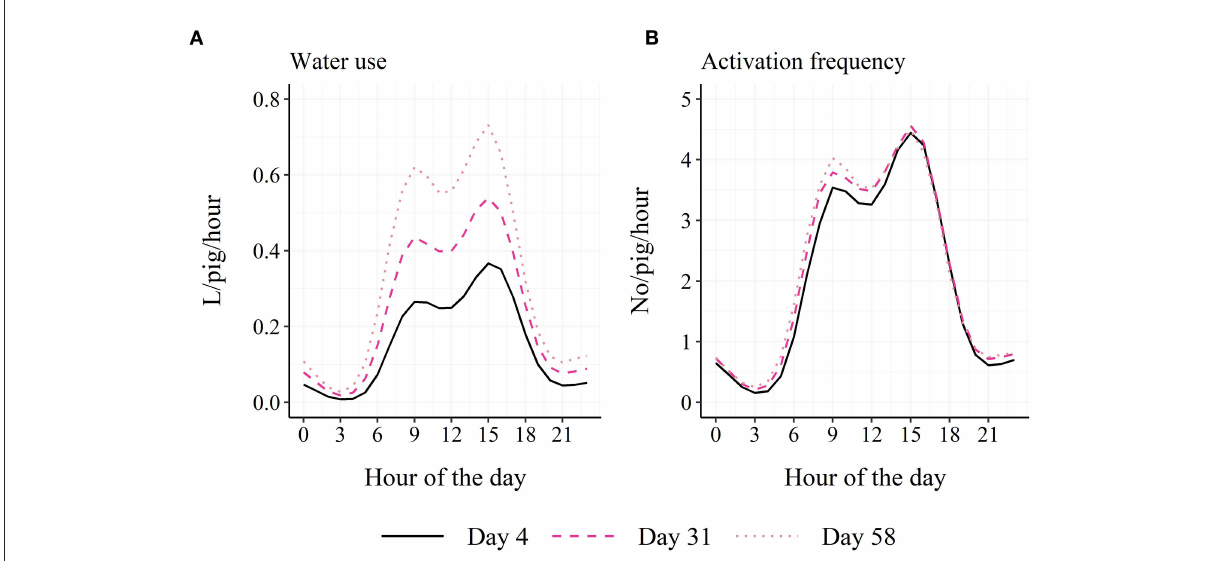
FIGURE3 Model-estimated diurnal pattern in water use (A) and activation frequency (B) in finisher pigs on day 4, day 31 and day 58 in the finisher unit.